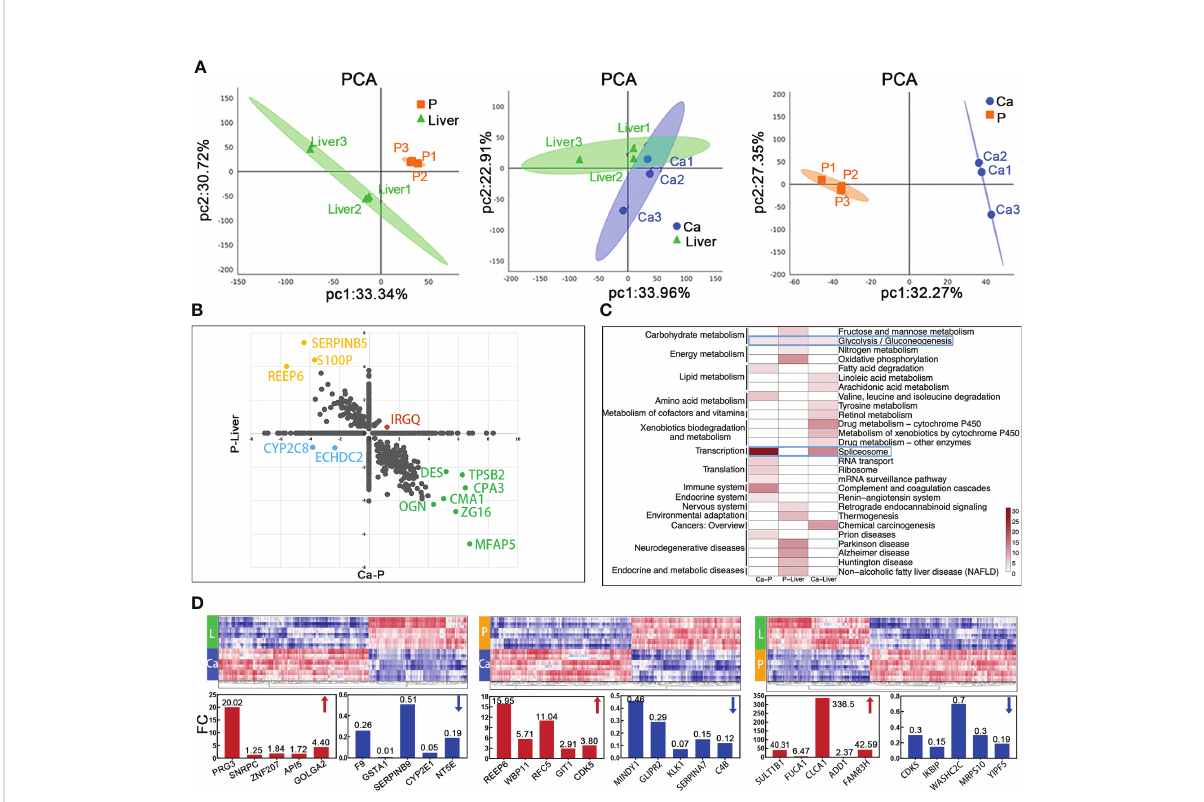
FIGURE 3 Mass spectrometric analysis about proteomics characterization of mCRC. (A) Principal-component analysis of protein expression in each group. (B) Merge of Ca-P and P-Liver proteomic data divide proteins in four groups. (C) The heatmap shows the signi fi cance of top 30 GO term being enriched by proteins in Ca-P, P-Liver and Ca-Liver. (D) Proteomic analysis reveals distinct protein expression patterns in paired tumor (Ca), para- tumor (P) and liver metastasis tissues (Liver). Heat maps of the differentially expressed proteins show clearly distinctive patterns of protein expression between disease